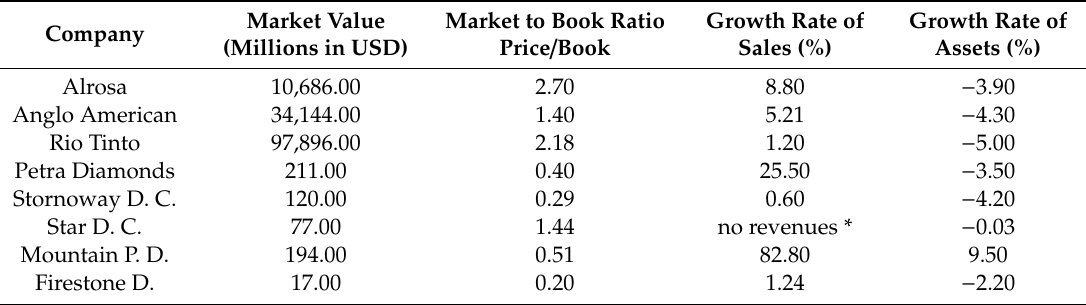
Table 2. Financial information of the 8 studied diamond-mining